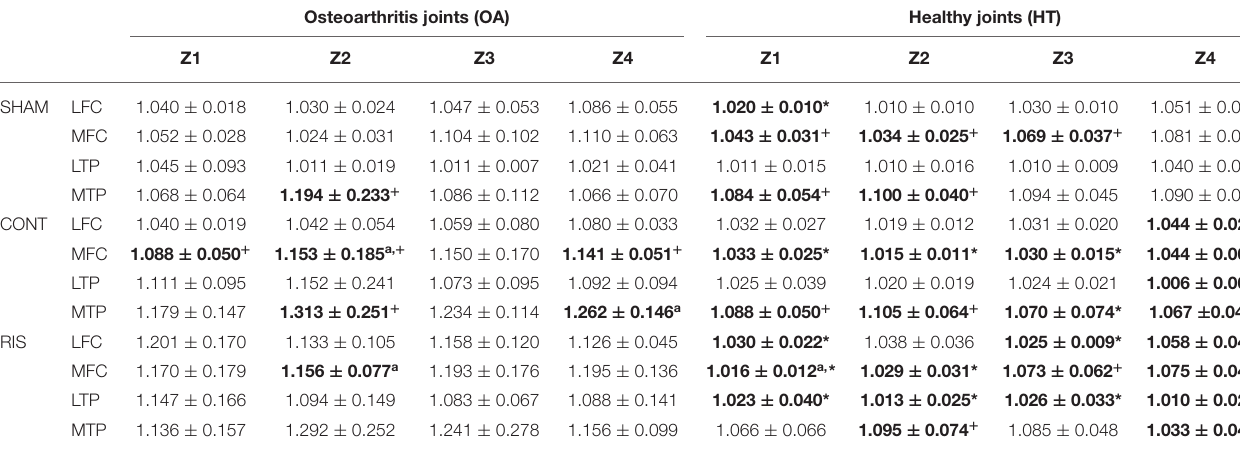
TABLE 3 | Fibrillation index in the four evaluated zones (Z1 to Z4). Osteoarthritis joints (OA)